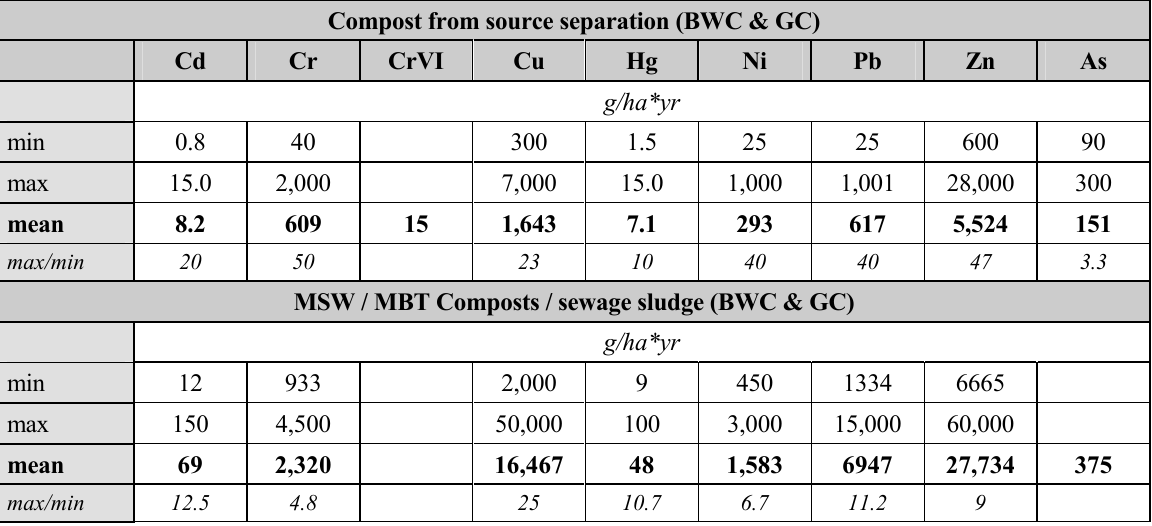
Table 30: Minimum, maximum and mean admitted yearly loads of PTEs in European soil protection, compost and sewage sludge